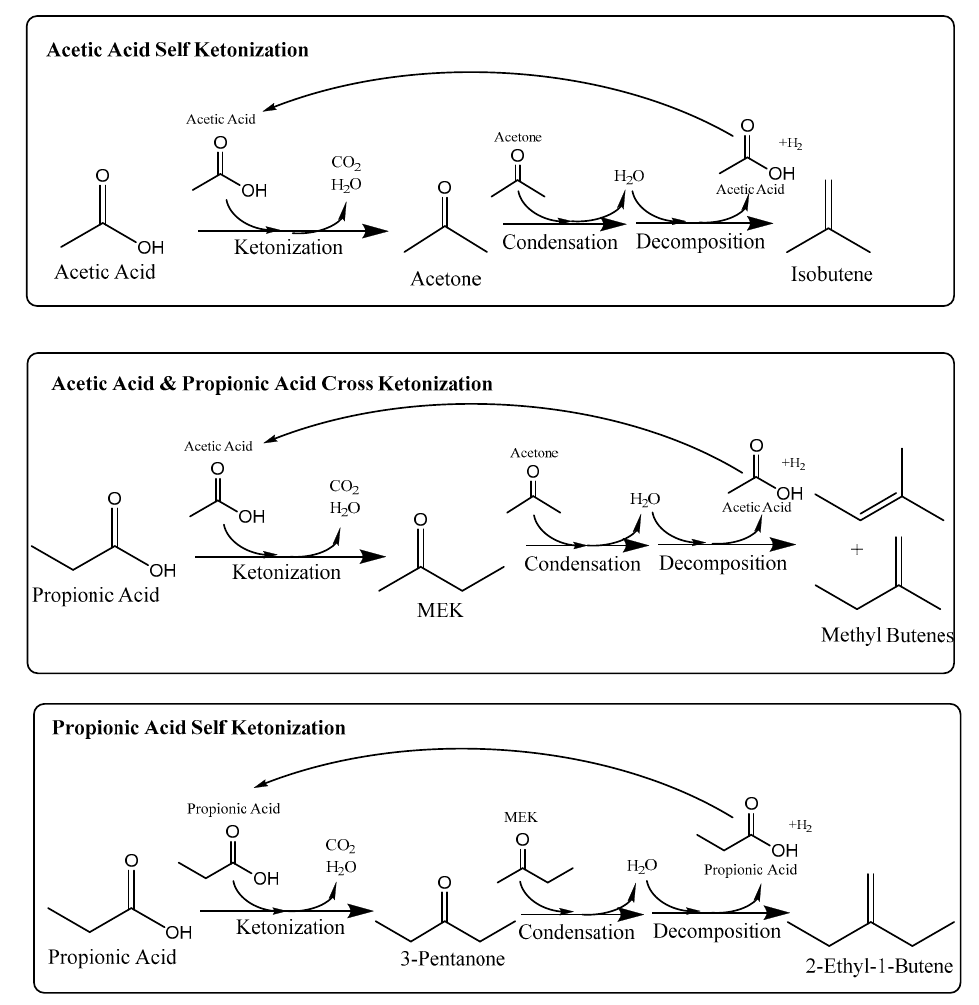
Figure 2. Gas hour space velocity (GHSV) profile of ( A ) PNNL-HTL feedstock, S/C = 2.8, and ( B ) KIT-SP feedstock, S/C = 4.7. Temperature: 450 °C, catalyst loading 0.7 g, N 2 50 vol%. Complete conversion of carboxylic acids was observed at all GHSV’s studied. 3-pentanone was observed in trace (0.21% for PNNL-HTL and 0.10% for KIT-SP) amounts at ~5400 h − 1 , but was otherwise not observed.